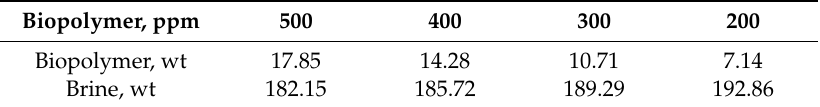
Table 2. Biopolymer solutions weight